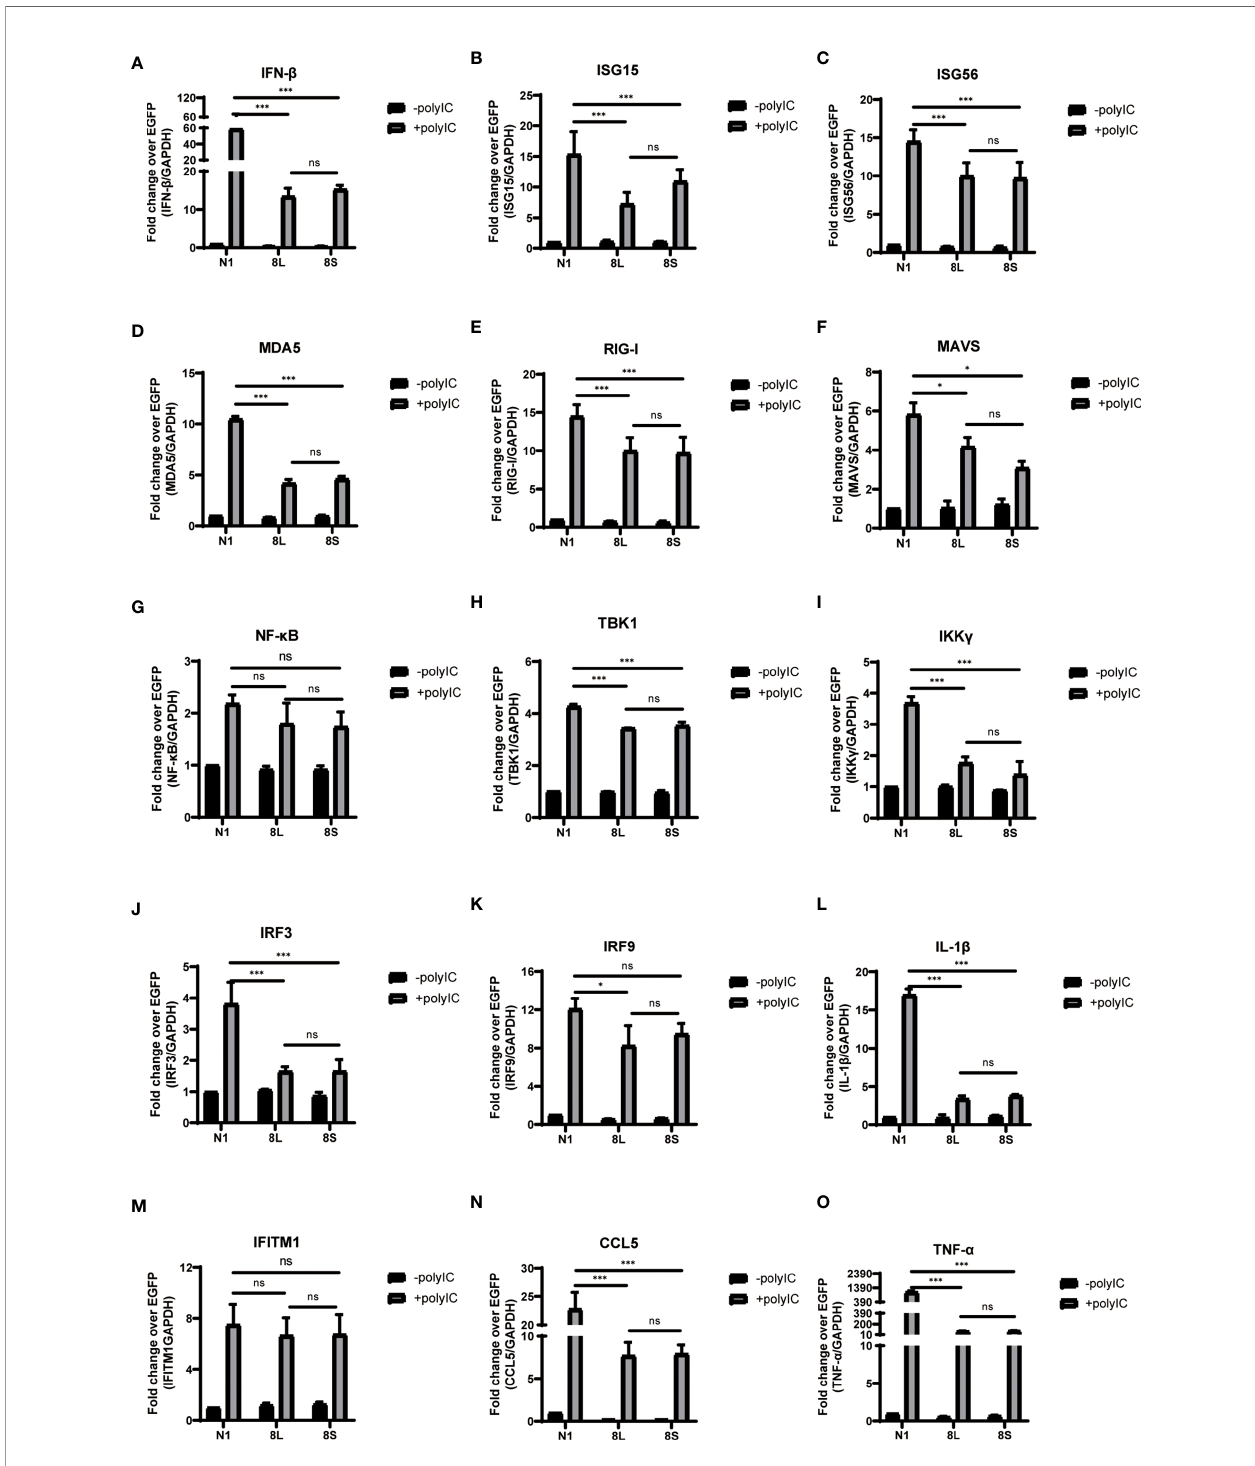
FIGURE 4 | The ORF8L and ORF8S proteins suppress the induction of cytokines in RLR pathways by poly(I:C) transfection. HeLa cells cultured in 12-well plates were co-transfected with control vector pEGFP-N1, pEGFP-ORF8L, and pEGFP-ORF8S, respectively, together with poly(I:C) (1 m g/ml). At 24 h post-transfection, cells were lysed and total RNA was then extracted for quantitative real-time RT-PCR with speci fi c primers for cytokines (A – O) . The expression of each gene was expressed relative to their respective control sample transfected with empty vector. ns, no signi fi cance; *P < 0.05; ***P < 0.001 versus empty vector (one-way ANOVA). Three independent biological replicates were analyzed, the results of one representative experiment are shown, and the error bars indicate the SD value. pEGFP-N1, N1; pEGFP-ORF8L, 8L; pEGFP-ORF8S,